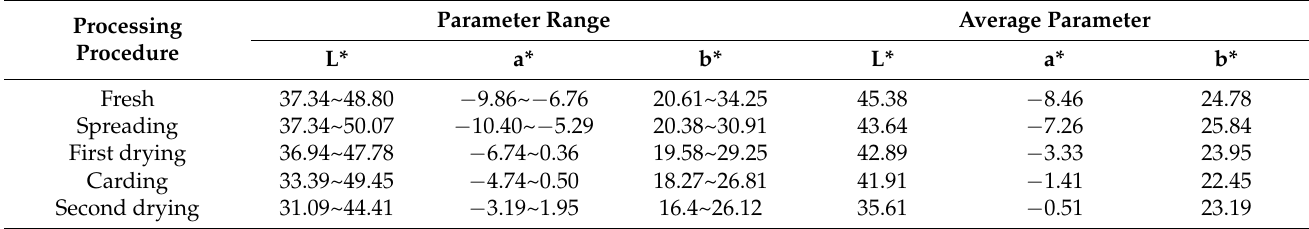
Figure 6. Three-dimensional (3D) load distribution map obtained from the results of PCA analysis conducted for colorimetric and gloss during tea processing.